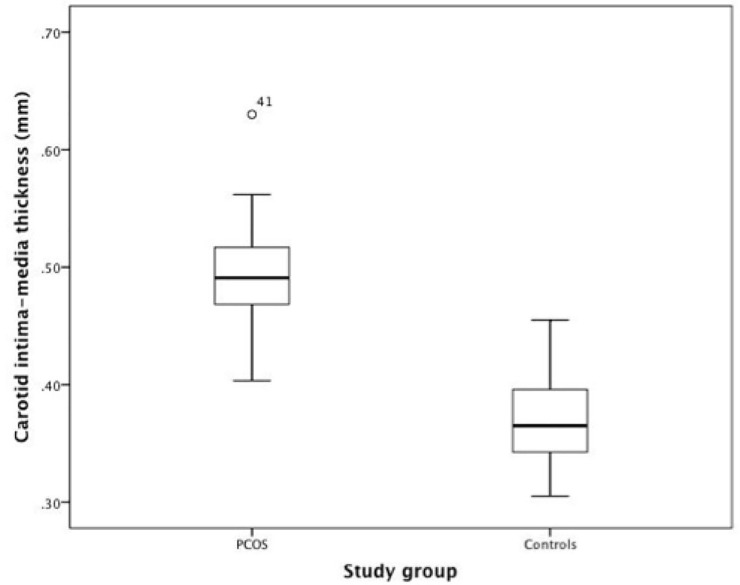
Box and whisker plots of CIMT.Among each group of interest (i.e. PCOS and controls). Box and whisker plots enable to summarize descriptive analysis of CIMT. They comprise the median (bold horizontal line) and the interquartile range (IQR), represented by a box, the first and third quartile being the borders of this box. Whiskers show values that are within 1.5 IQRs (vertical lines extending from the box). The small circle indicates an outlier (over 1.5 IQRs).